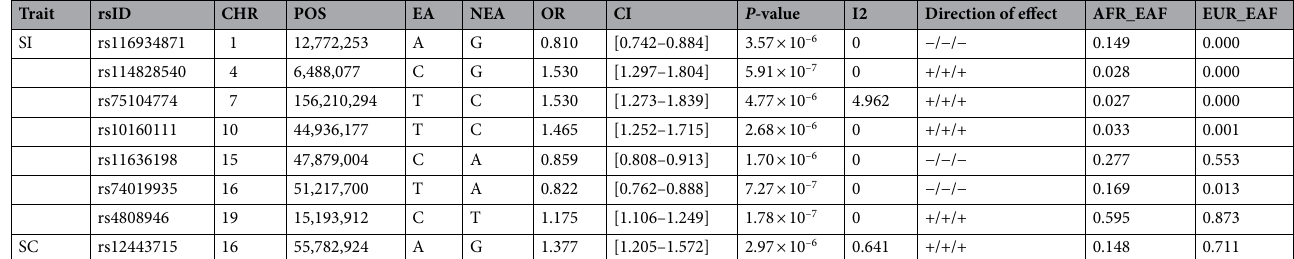
Table 2. Meta-analysis sentinel variants for smoking initiation (SI) and smoking cessation (SC). rsID rs number, CHR chromosome, POS b37 position, EA effect allele, NEA non-effect allele, OR odds ratio, CI 95% confidence interval. I2: percentage of total variation across studies due to heterogeneity. Direction of effect: in order, AWI-Gen, UKB-AFR, UGR. AFR_EAF: effect allele frequency in AFR 1000GP 30 . EUR_EAF: effect allele frequency in EUR 1000GP 30